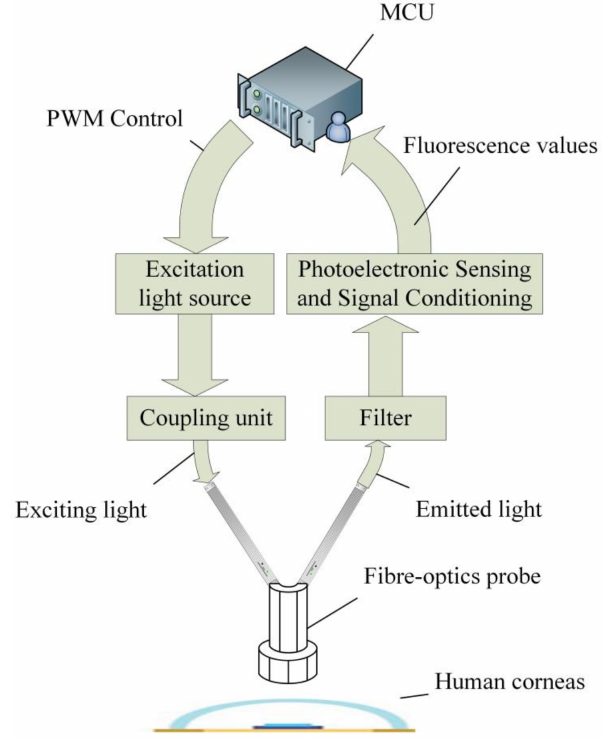
Figure 2. Structure of the device.